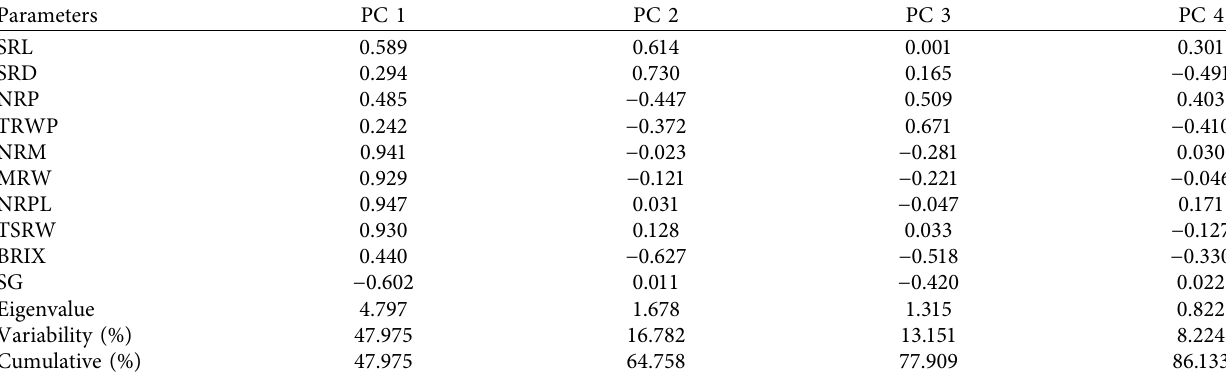
Table 7: Factor loadings, agronomic trait markers, contributed to variability in PFSP at Majalengka. Parameters